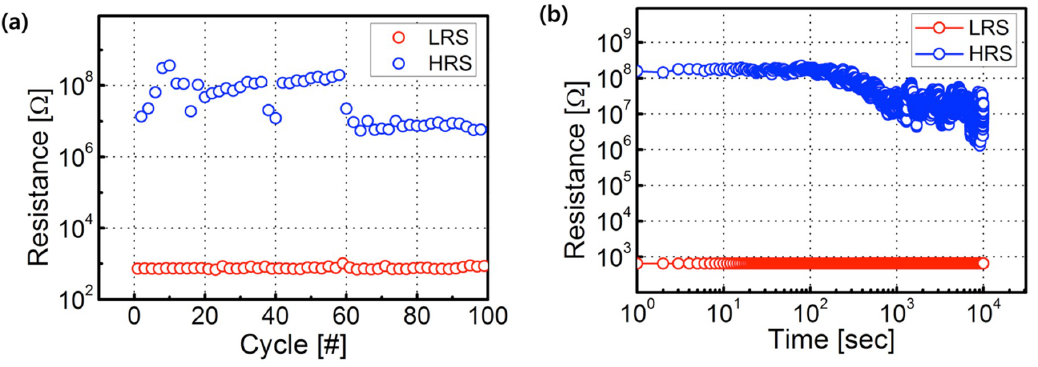
Figure 6. ( a ) Representative endurance properties and ( b ) retention properties of RRAM devices consisting of ZrO 2 films annealed in